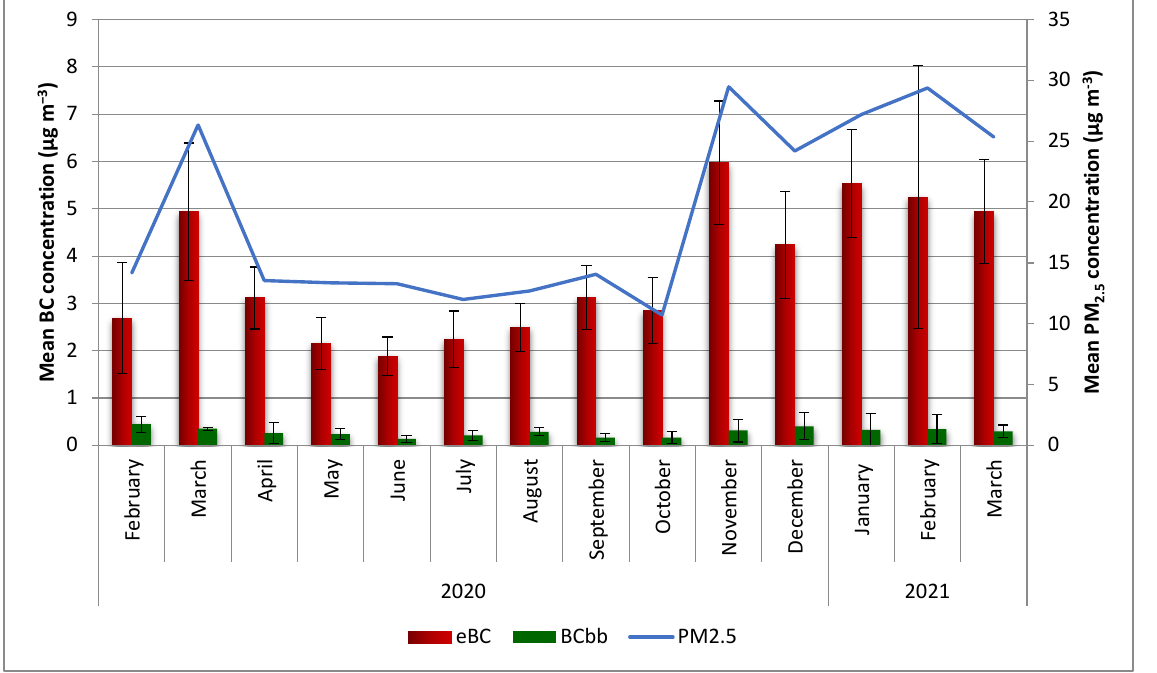
Figure 5. Mean monthly concentrations of eBC and BC bb together with PM 2.5 in µg m −3 for sampling from Krakow during 2020–2021.